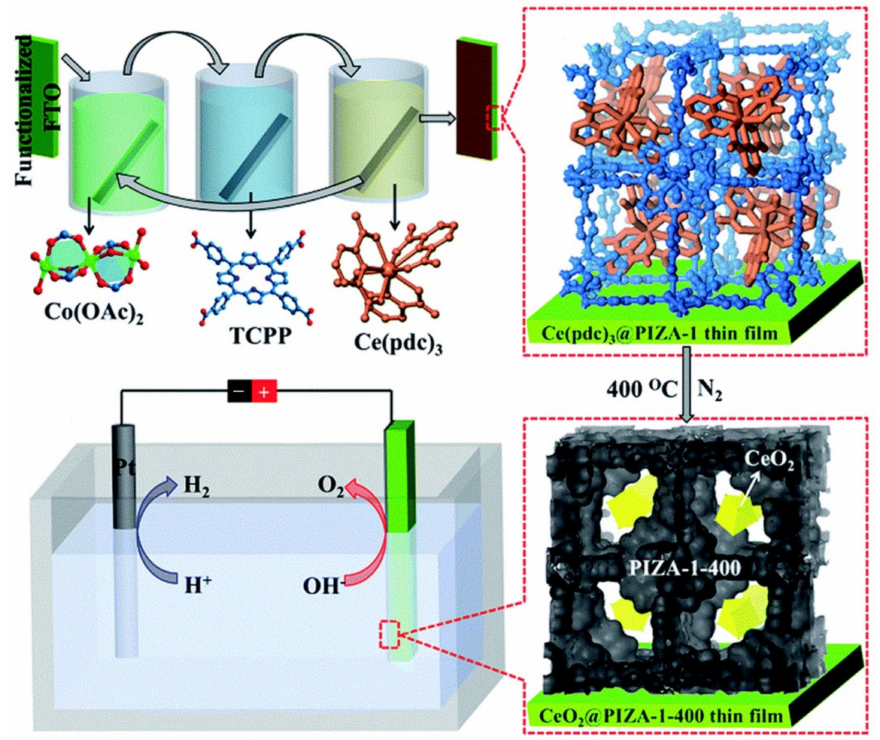
Figure 10. Schematic representation of the preparation process and electrocatalytic water splitting of CeO 2 @PIZA-1 thin film. Reprinted with permission from ref. [66]. Copyright The Royal Society of Chemistry